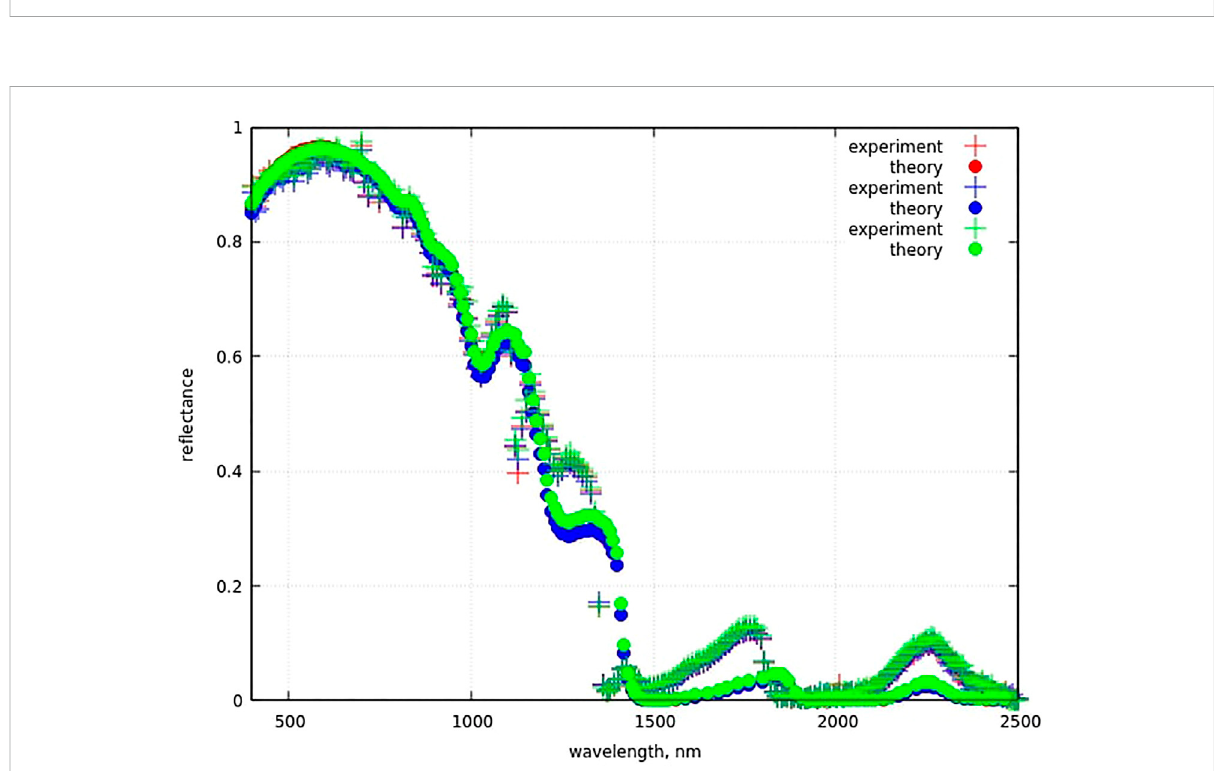
FIGURE 5 The intercomparison of theory and experimental data for the whole measured spectral range (for the cases 6 – 8 in Table 3).